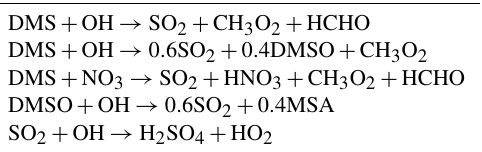
Table 2. The oxidative pathways relevant to DMS in ACCESS- UKCA as defined in Pham et al. (1995).